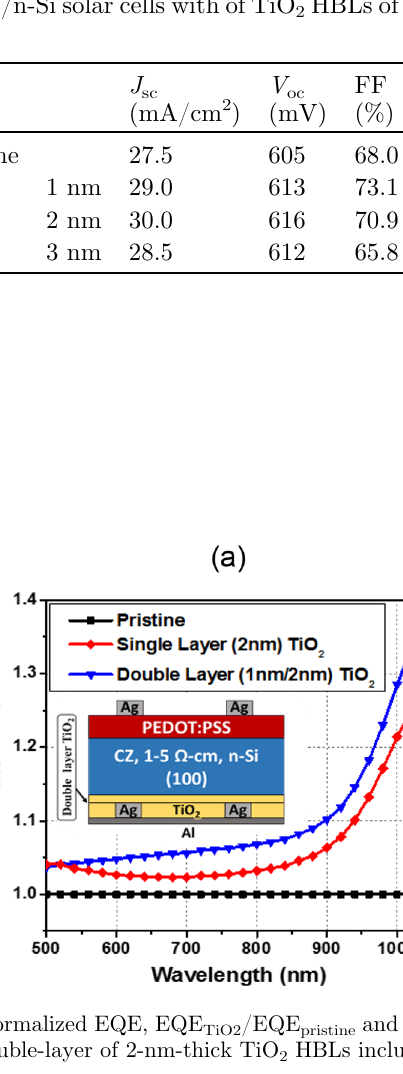
, V , FF, and PCE of sc oc HBLs of various 2